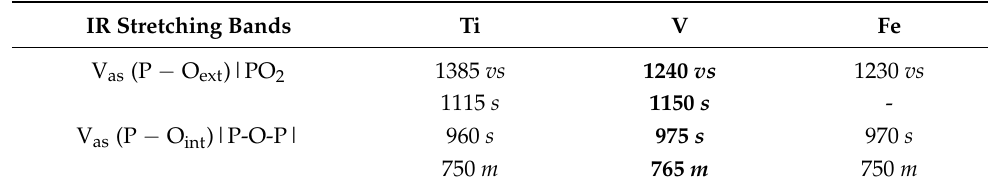
Table 2. Comparison of the stretching frequencies of metaphosphate compound M(PO 3 ) 3 where M = V, Fe, and Ti.